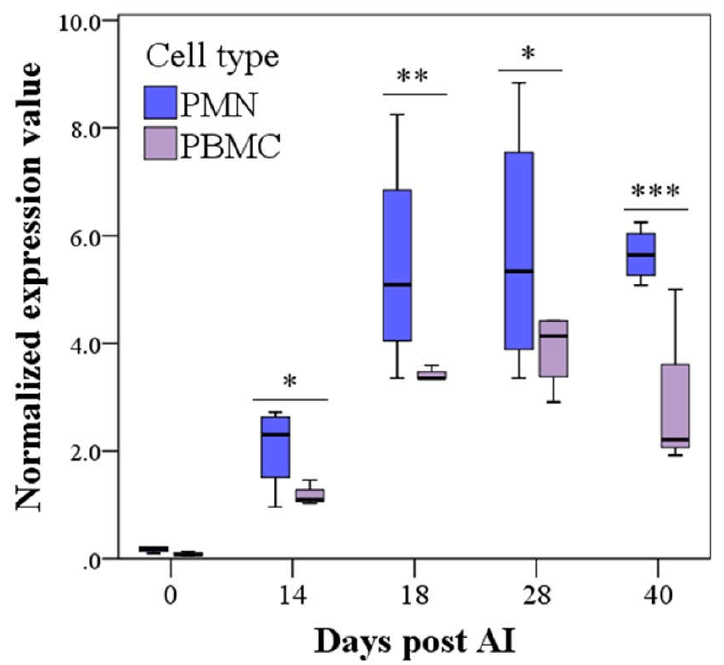
Figure 3. PAG2 expression in granulocytes (PMN, 2 −ΔCt ) and peripheral blood mononuclear cell (PBMC, 2 −ΔCt ) until Day 40 post AI in Pregnant buffaloes (mean ± SE, raw data). PAG2 expression was higher in PMN than PBMC from Day 14 post artificial insemination (AI; *** p < 0.001, ** p < 0.01, * p < 0.05 PMN vs. PBMC for each day).